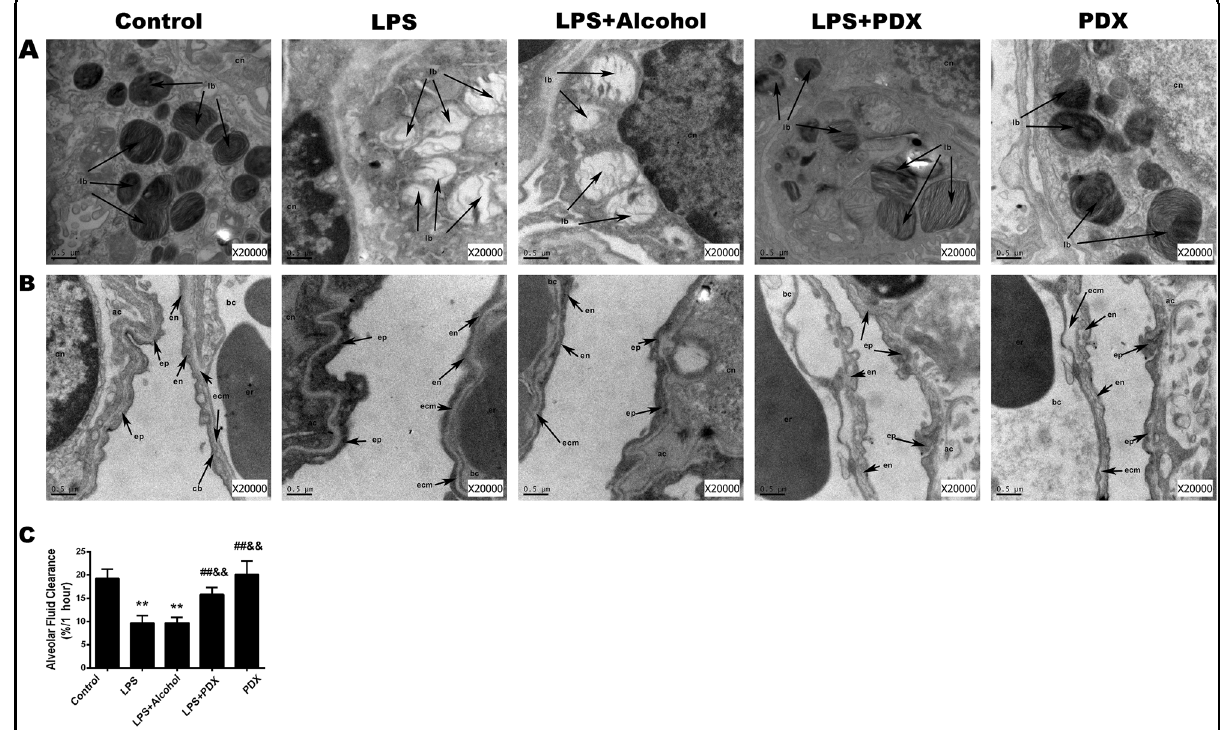
Fig. 2 Effects of protectin DX on lung tissue ultrastructure and alveolar fl uid clearance in LPS-induced acute lung injury in vivo. Protectin DX (5 µg/kg) was injected into the caudal veins of Sprague-Dawley rats 8 h after LPS (14 mg/kg) stimulation; the rats were then ventilated for 60 min, and the effects of protectin DX were assessed by electron microscope photomicrographs of the lung tissues from rats. The lamellar bodies in the LPS group were severely vacuolated compared with those in the control group; however, the lamellar body damage was recovered in the protectin DX treatment group ( a ). The control group presented a normal air – blood barrier. In contrast, the air – blood barrier in the LPS group was damaged and had broken epithelial bridges and capillary walls in the tissues. In the treatment group, protectin DX signi fi cantly improved the damage to the air – blood barrier induced by LPS ( b ). lb lamellar body, bc blood capillary, ac air capillary, ep epithelial bridge, en endothelial cell, ecm extracellular matrix of the capillary wall, cn cell nucleus, er erythrocyte. After intratracheal instillation of a 5% albumin solution containing Evans blue-labeled albumin (5 ml/kg) through a tracheostomy to the left lung, alveolar fl uid clearance was measured over 60 min in ventilated animals ( c ). The data are presented as the mean ± SD. n = 8. PDX protectin DX. Alcohol was the solvent for protectin DX. ** p < 0.01 versus the control group; †† p < 0.01 versus the LPS group; ‡‡ p < 0.01 versus the LPS + alcohol